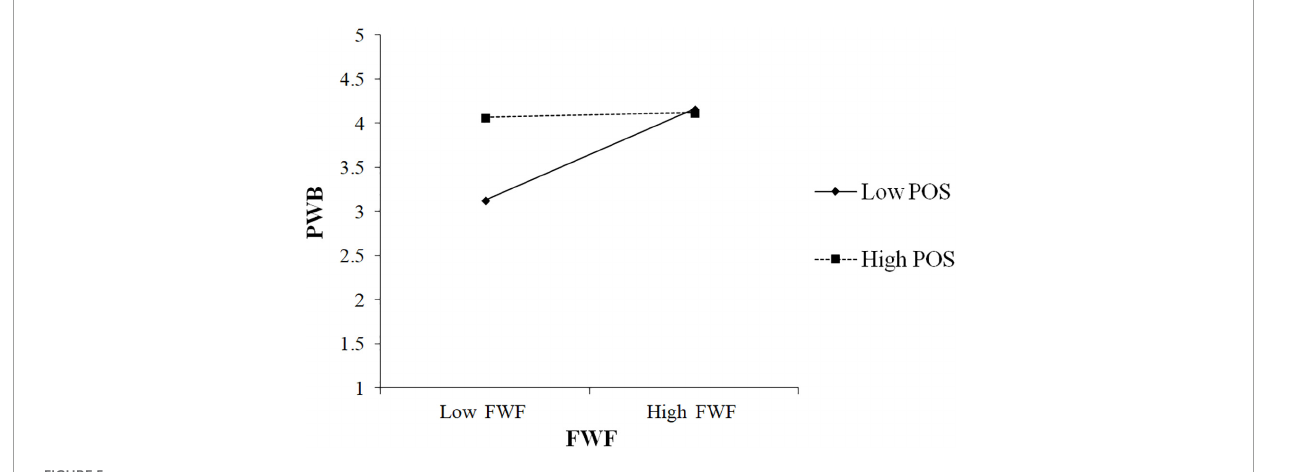
FIGURE5 Effects of family-work facilitation (FWF) and POS on